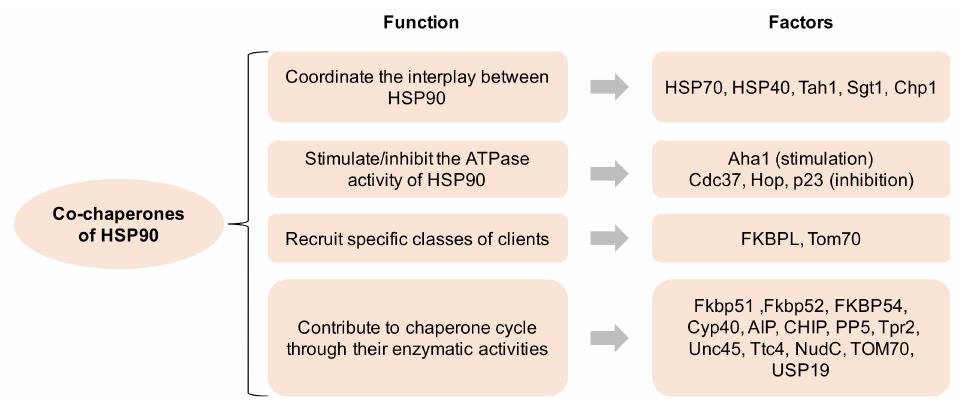
Figure 1. Co-chaperones of HSP90 and its function. HSP90 comprises four isoforms: (1) HSP90 α (an inducible form) and HSP90 β (a constitutive form) are mainly located in the cellular cytosol; (2) the glucose-regulated protein (GRP94) is localized in the endoplasmic reticulum; (3) Hsp75/tumor necrosis factor receptor associated protein 1 (TRAP-1, also known as mitochondrial HSP90) is located on the mitochondria [7,8]. All HSP90 isoforms play critical roles in cancer, neurodegenerative disorders, and other disease states, indicating that their pharmacological targeting may have profound implications for the treatment of these illnesses